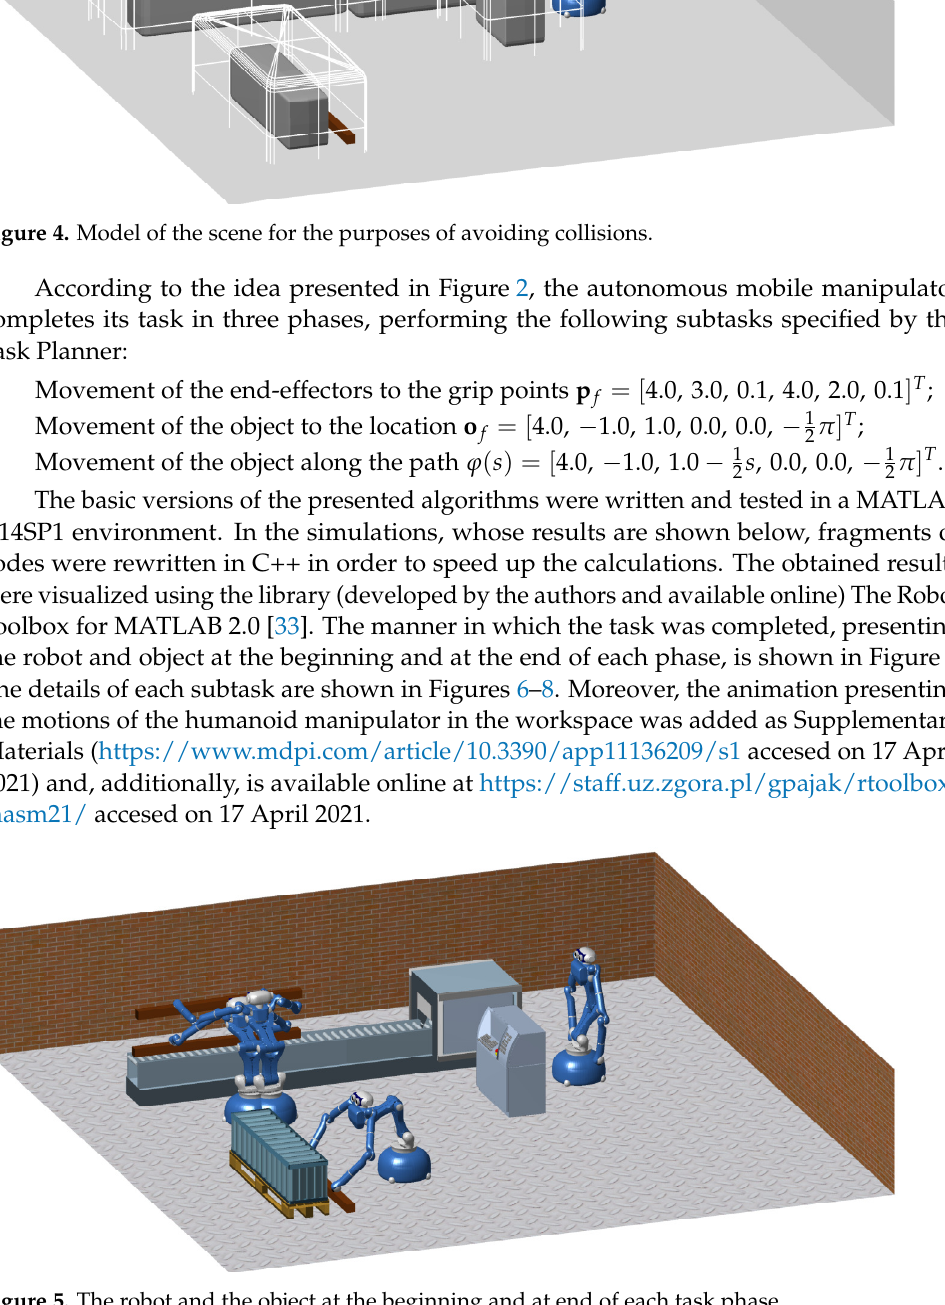
Figure 5. The robot and the object at the beginning and at end of each task